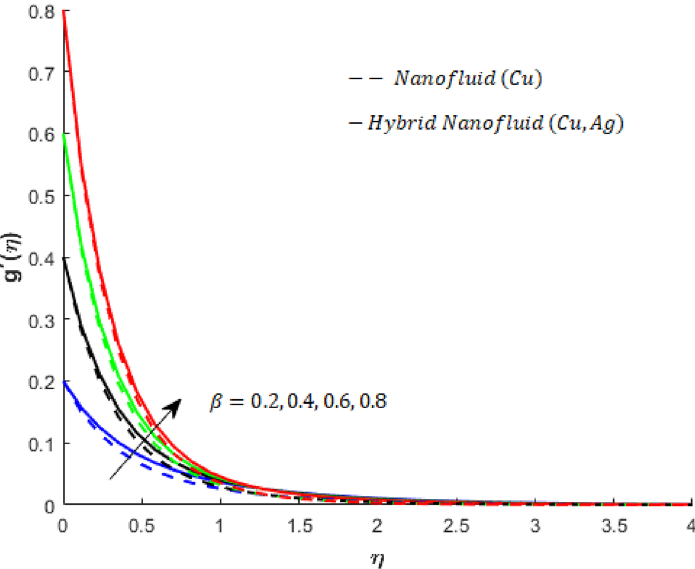
Figure 5. Influence of β on g ′ when ( Gr ) t = 0.5, Pr = 4, Sc = 5, K ∗ = 0.1, Ec = 0.001, ( Gr ) c = 0.3, M = 0.5, β ∗ = 0.2, Sr = 0.1 and 0.2 . Du =